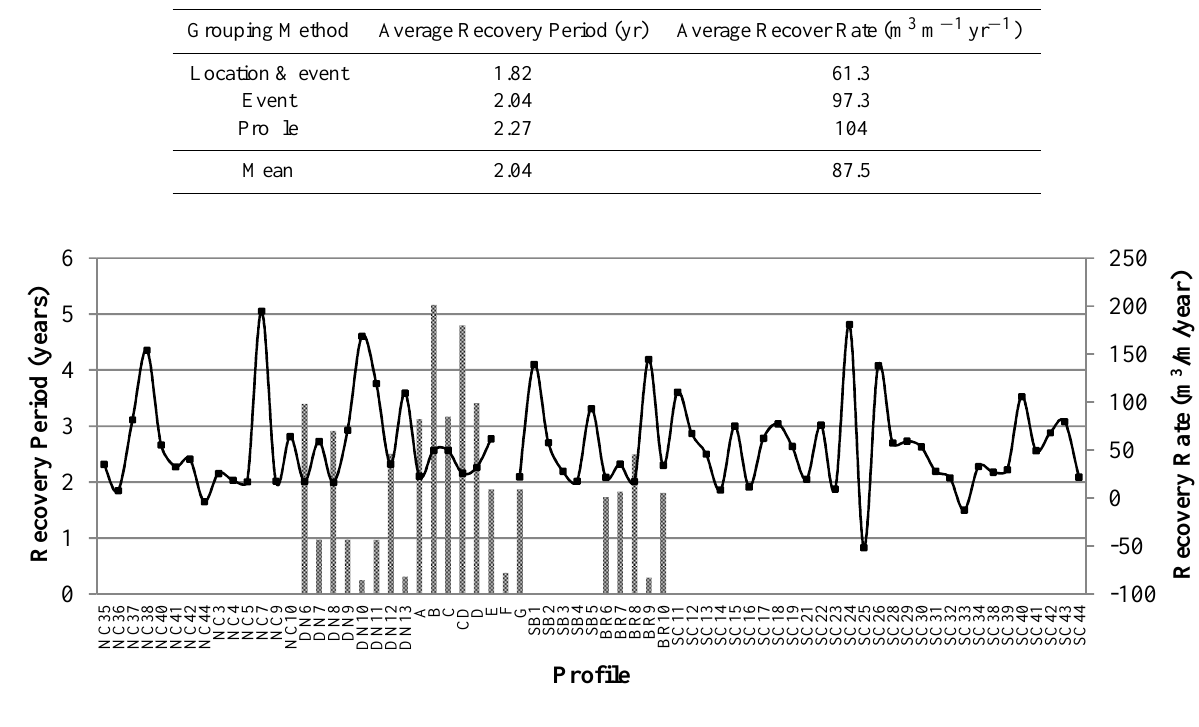
Fig. 9. Profile volume recovery period and recovery rate of the 2007 event shown by the bar graph and line graph, respectively.